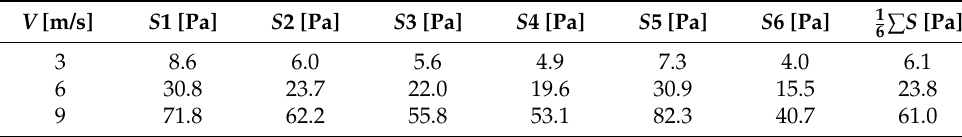
Table 5. Pressure-differential readings at 5 ◦ AOA for different